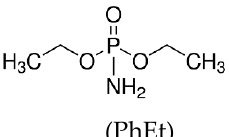
Table 4. Fire retardance performances of different polymers (data adapted from ref. [61,62]).